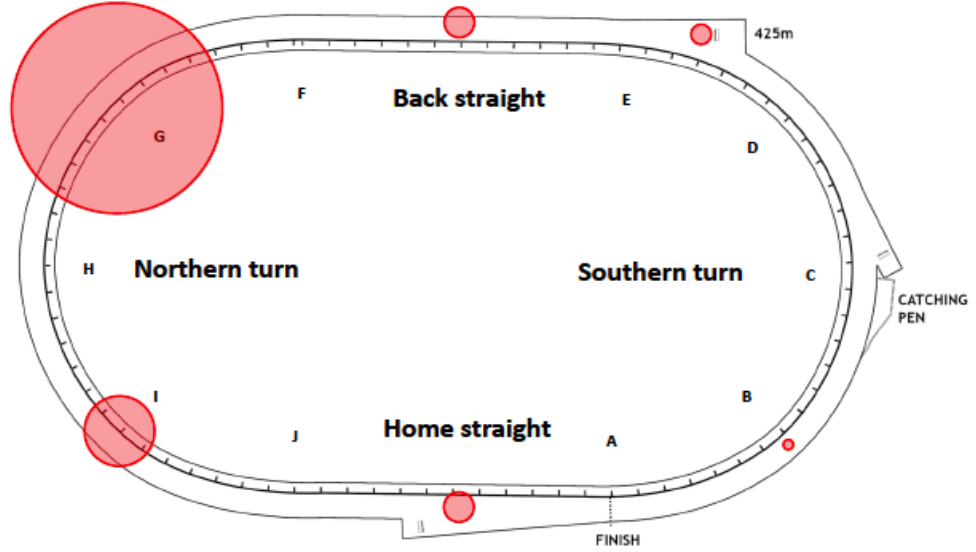
Figure 8. The de-identified greyhound track injury location heat map for the 425 m start. The magnitude of the normalised injury rate is depicted by the relative radius of the red